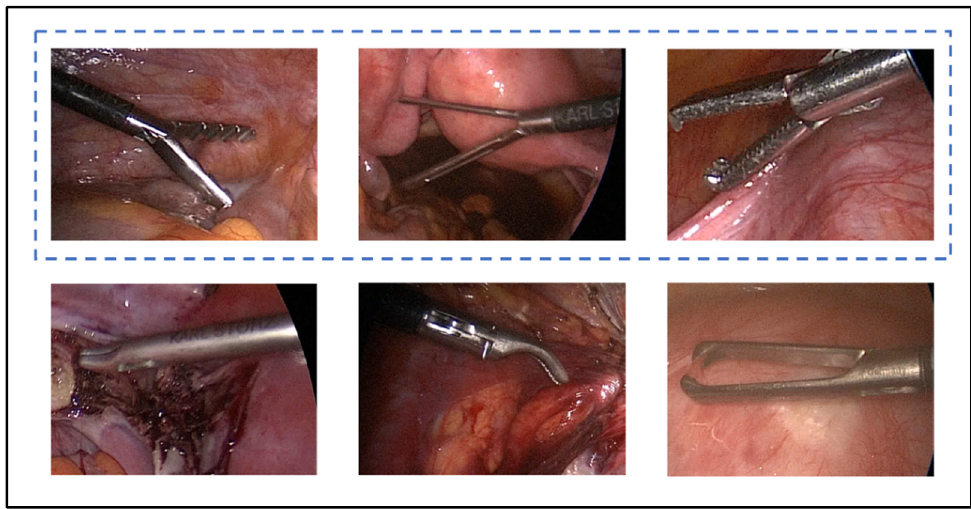
Figure 1. Different types of graspers in the Gyna08 dataset. The tools in the blue dashed box form the main grasper class.